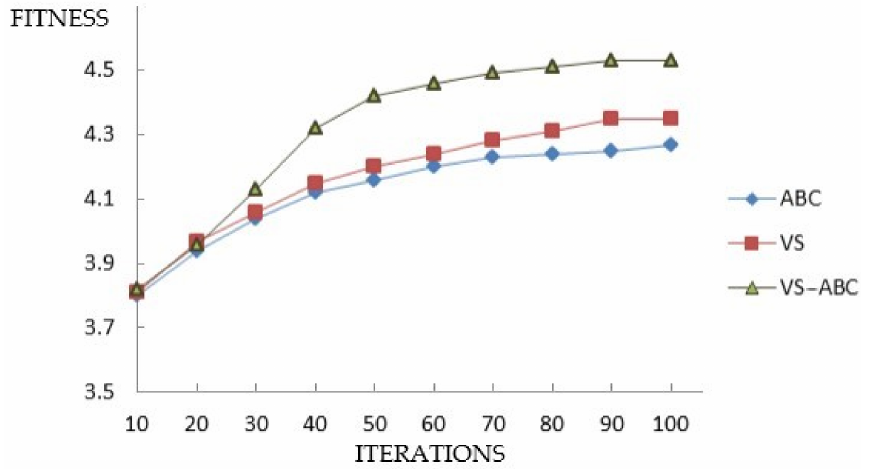
Figure 8. The trend of average fitness for 50 tasks for three